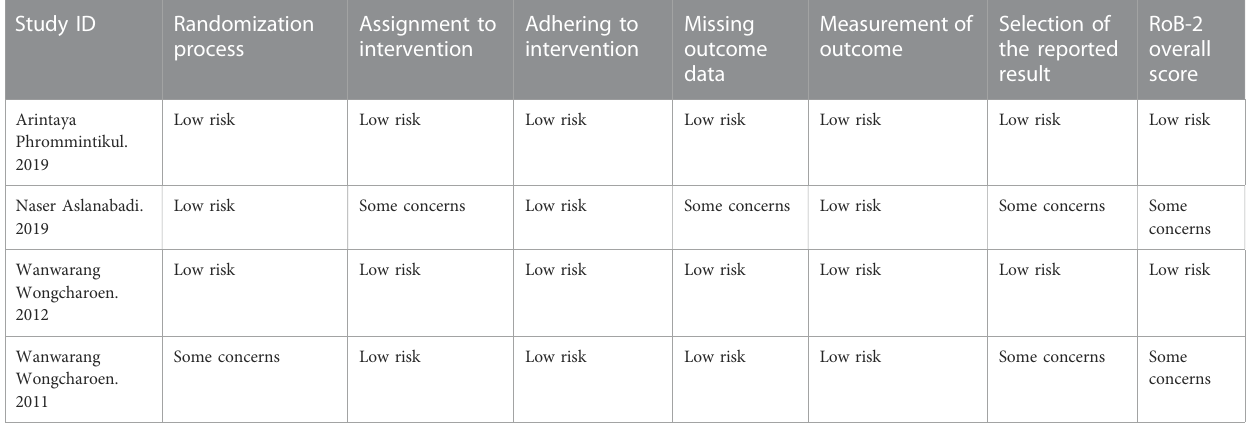
Selection of the